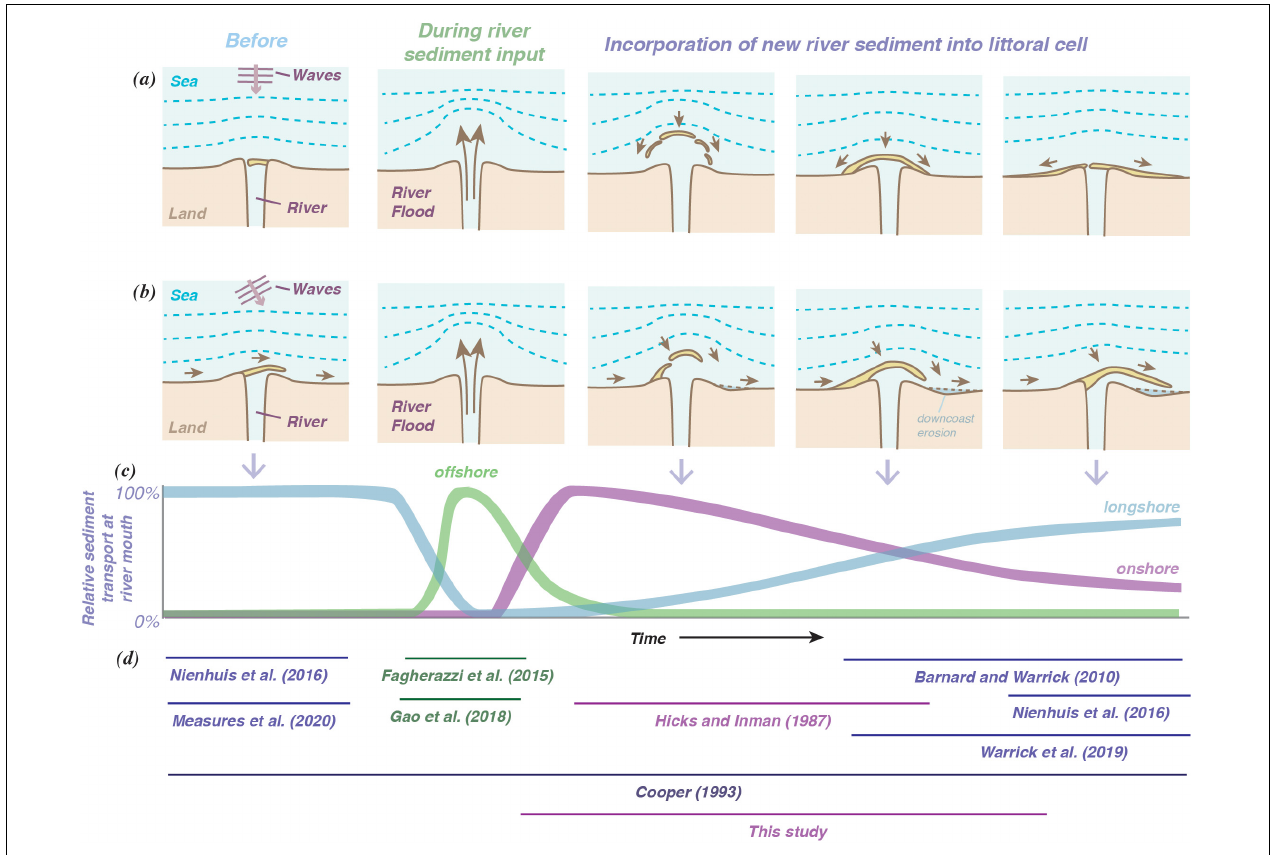
FIGURE 13 | Generalized schematic of sediment from rivers into littoral cells showing the morphodynamic stages before, during and after input. (a) Top row shows a scenario in which ocean waves approach normal to the shoreline; (b) the bottom row shows the effects of oblique wave directions. Sediment transport vectors from fluvial and littoral processes are shown with brown arrows. (c) A generalized model for post-event sediment transport directions. (d) References that provide further information about the patterns and processes of river mouth morphodynamics; horizontal lines highlight the applicable stages and processes of each